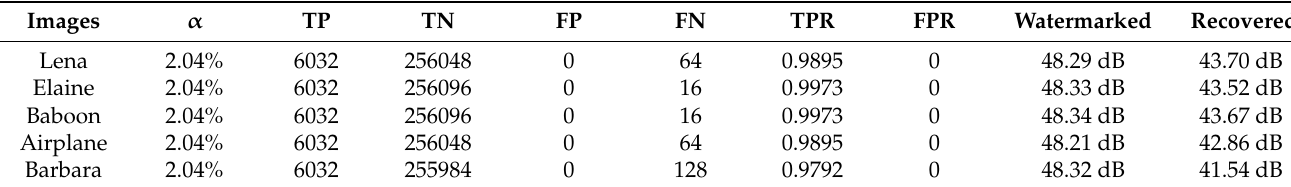
Table 1. Tamper localization and recovery analysis against cutting attack 1.